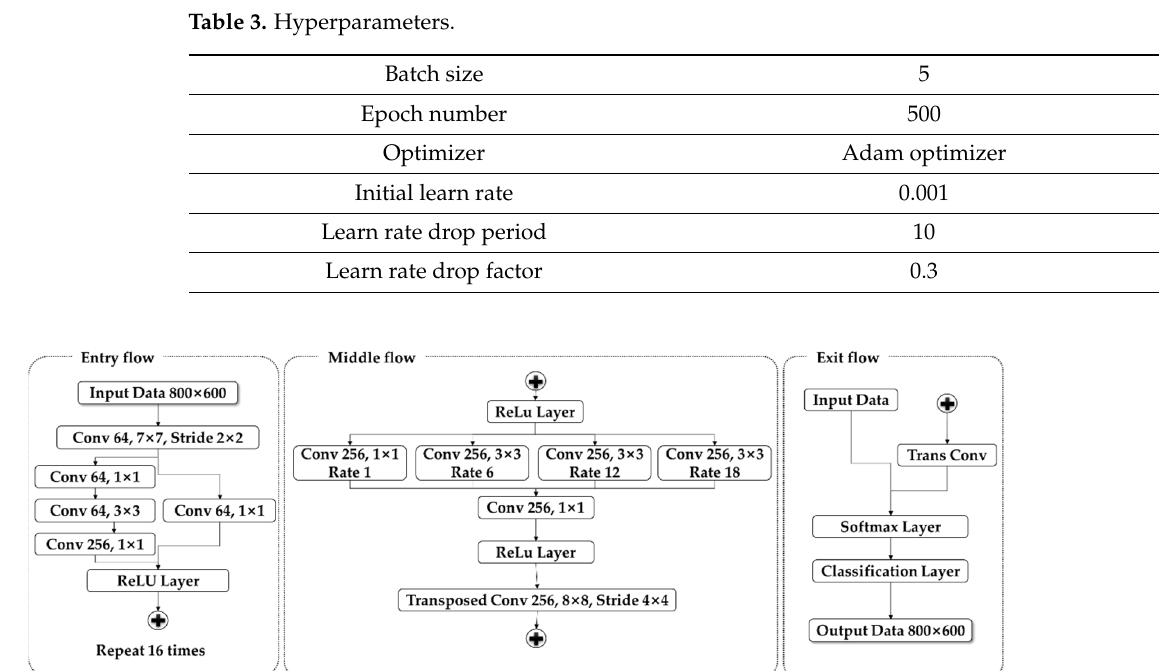
Figure 9. Overview of the holdout method.